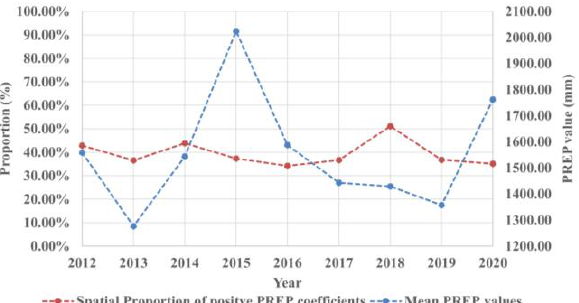
Figure 15. Temporal trends of mean PREP values and spatial proportion of positive PREP coeffi- cients.